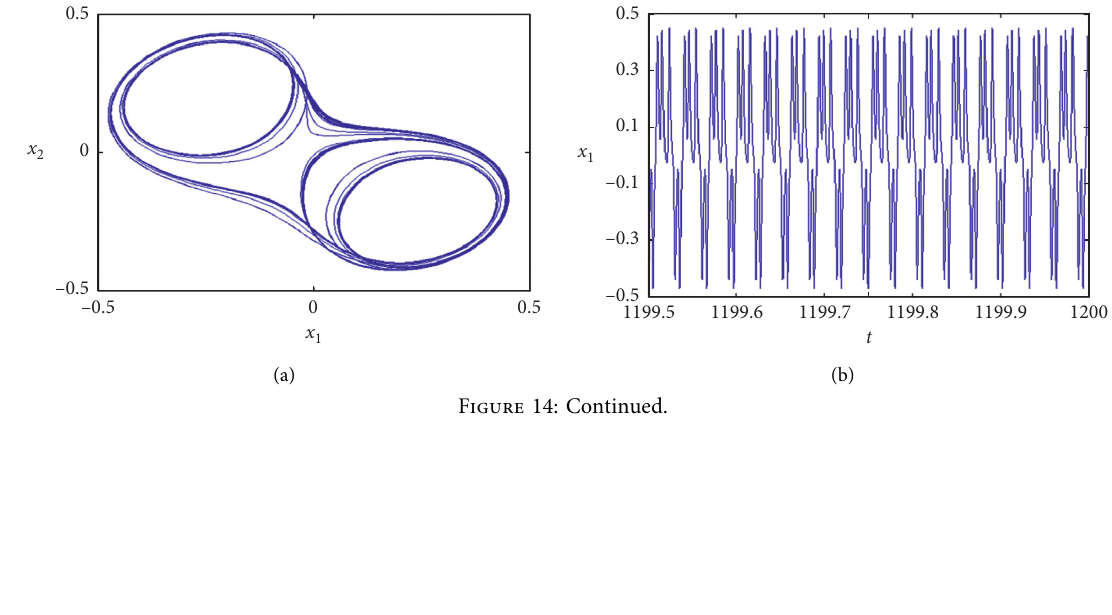
, x ) , (b) waveform on plane ( t, x ) , (c) phase portrait on plane ( x 1 2 1 , x ,x ) , and (g) Poincare map on plane ( x 1 2 3